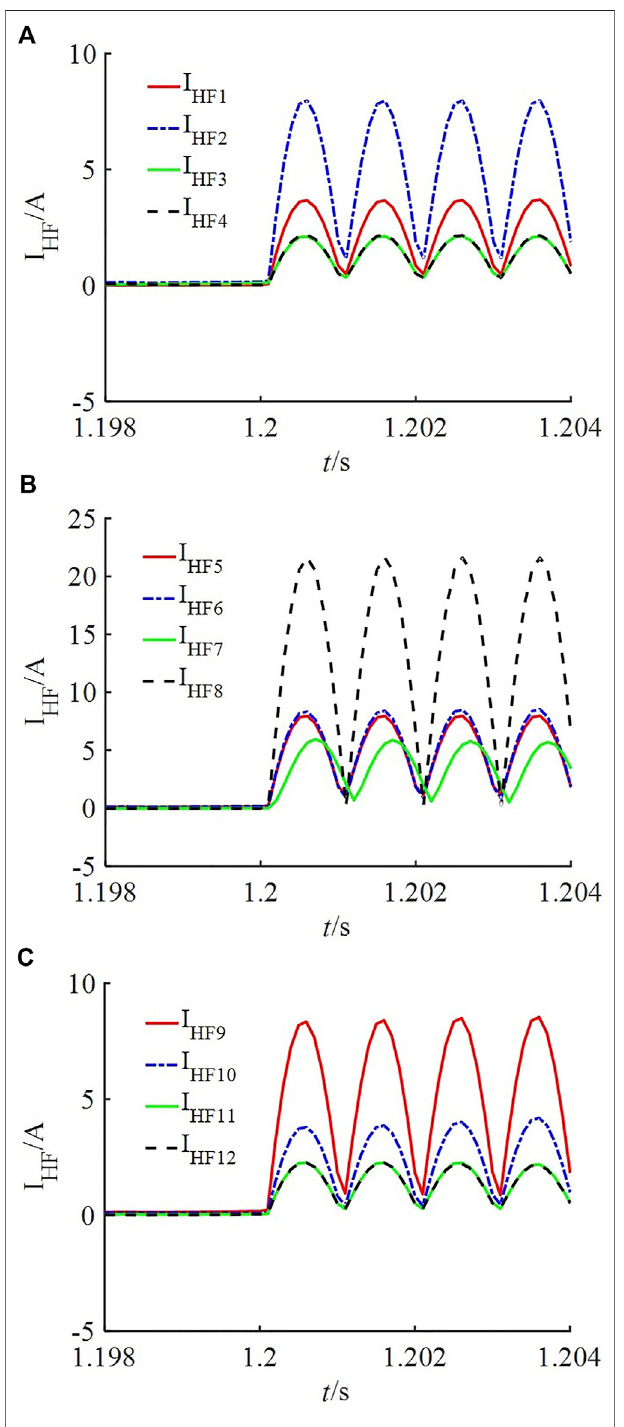
FIGURE 8 | High-frequency current waveforms when the load changes suddenly (A) PZ I (B) PZ II (C) PZ III.